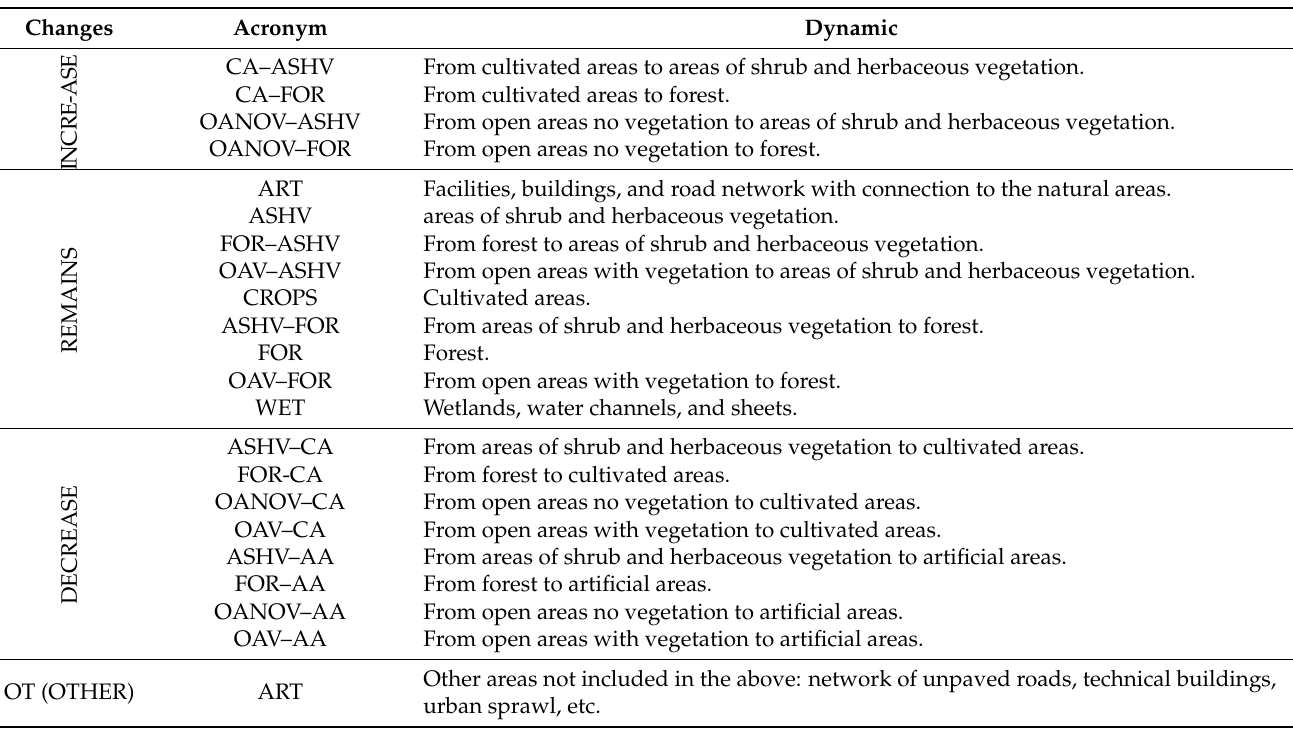
Table 10. Legend dynamics of changes: acronym legend.